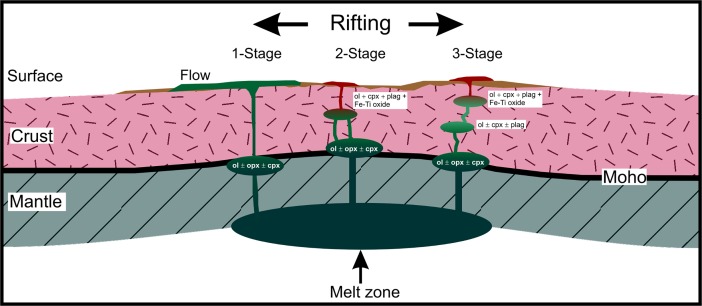
Conceptual crystallization scenarios of the parental magma of the Vega 2 rock.The 1-Stage differentiation scenario is deep seated fractionation primarily of olivine (ol) but may also include orthopyroxene (opx) and clinopyroxene (cpx). The 2-Stage scenario follows the 1-Stage scenario but the residual liquid stalls in the middle to upper crust and continues to differentiate into a silicic liquid due to fractionation of olivine (ol), clinopyroxene (cpx), plagioclase (plag) and Fe-Ti oxide minerals (ilmenite and magnetite). The 3-stage scenario follows the 1-Stage scenario of differentiation but has two steps of fractionation in order to generate a silicic residual liquid. The first step is fractionation of olivine (ol), clinopyroxene (cpx) and plagioclase (plag) at an intermediate depth in the middle crust or lowermost upper crust. The residual liquid then leaves the magma chamber and stalls in the upper crust and continues to differentiate by fractionating clinopyroxene (cpx), plagioclase (plag), Fe-Ti oxide minerals (ilmenite and magnetite) and possibly olivine (ol) before producing a silicic residual liquid.